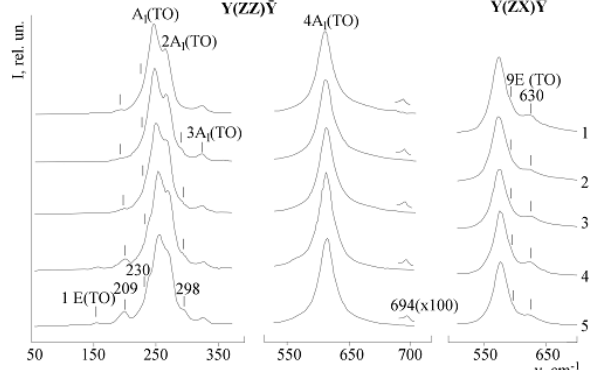
Figure 14. Fragments of Raman spectra of heavily doped LN single crystals in the scattering geometries Y(ZZ)¯Y and Y(ZX)¯Y: 1—CLN; 2—LiNbO 3 :Zn (4.5 mol.%); 3—LiNbO 3 :Mg:Fe (5.01; 0.005); 4—LiNbO 3 :Mg (5.1); 5—LiNbO 3 :Mg(5.3). T = 100K. The figure is reproduced with the permission of Pleiades